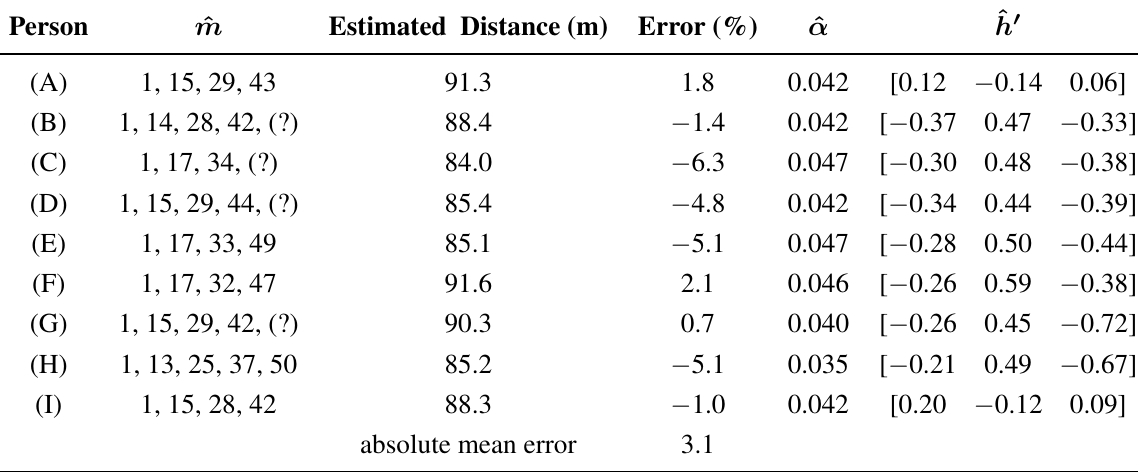
Table 3. 60 cell (89.7 m) walking test (‘?’ symbol means the segment is too short for the location